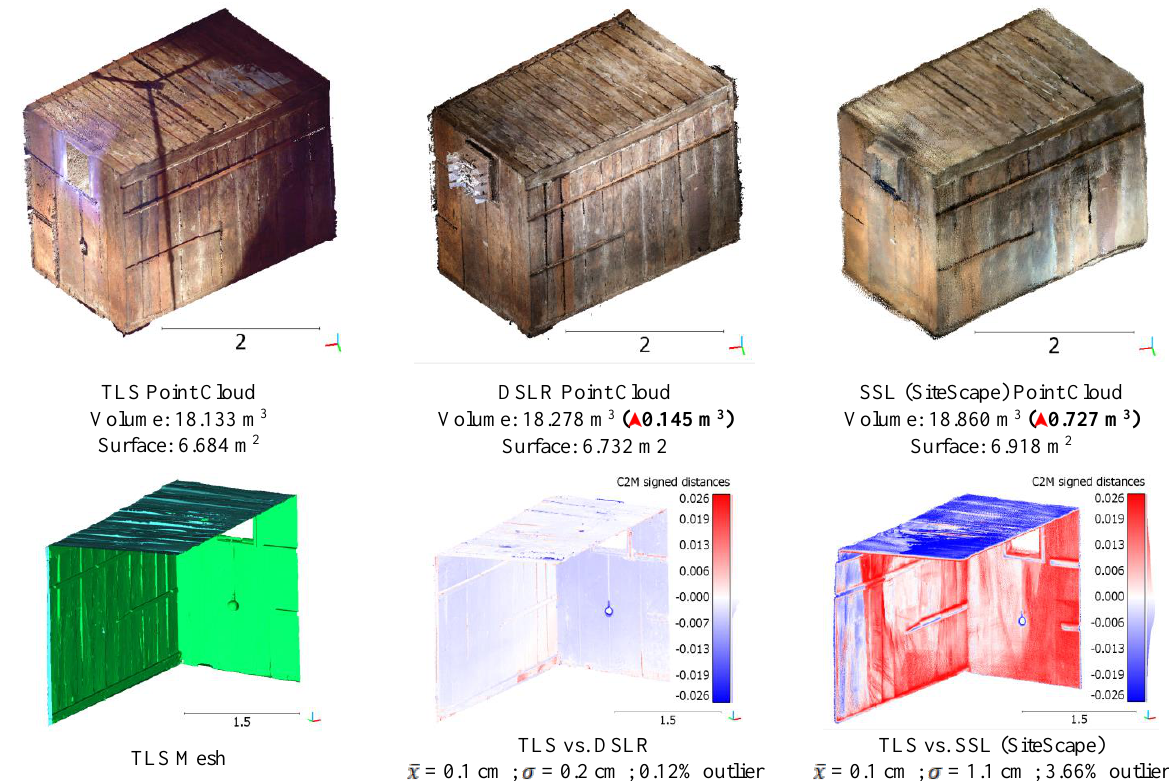
Figure 4. Results and comparison of the tested techniques for case (3). For this figure, the volume of the 3D space and a mesh-to- cloud analysis were performed using the TLS point cloud and mesh as reference data. denotes average deviation in 3D Euclidean distance, denotes standard